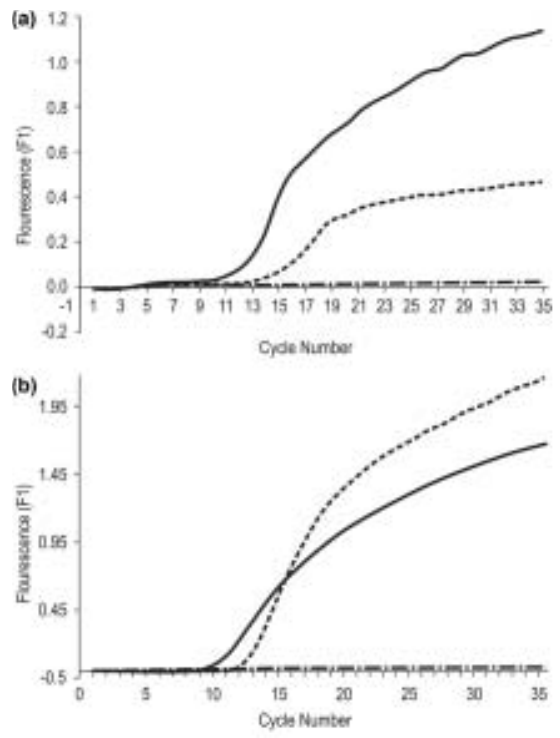
Figure 1 LightCycler TM PCR graph showing hybridiza- tion probe (GBS) and Taqman ( E. coli ) results, demonstrating (A) increased fluorescence for group B streptococci (solid) positive controls (dash), and (B) E. coli (solid) positive controls (dash). No fluorescence was observed for the negative control (PCR grade water) and patients’ samples negative for GBS or E. coli (broken